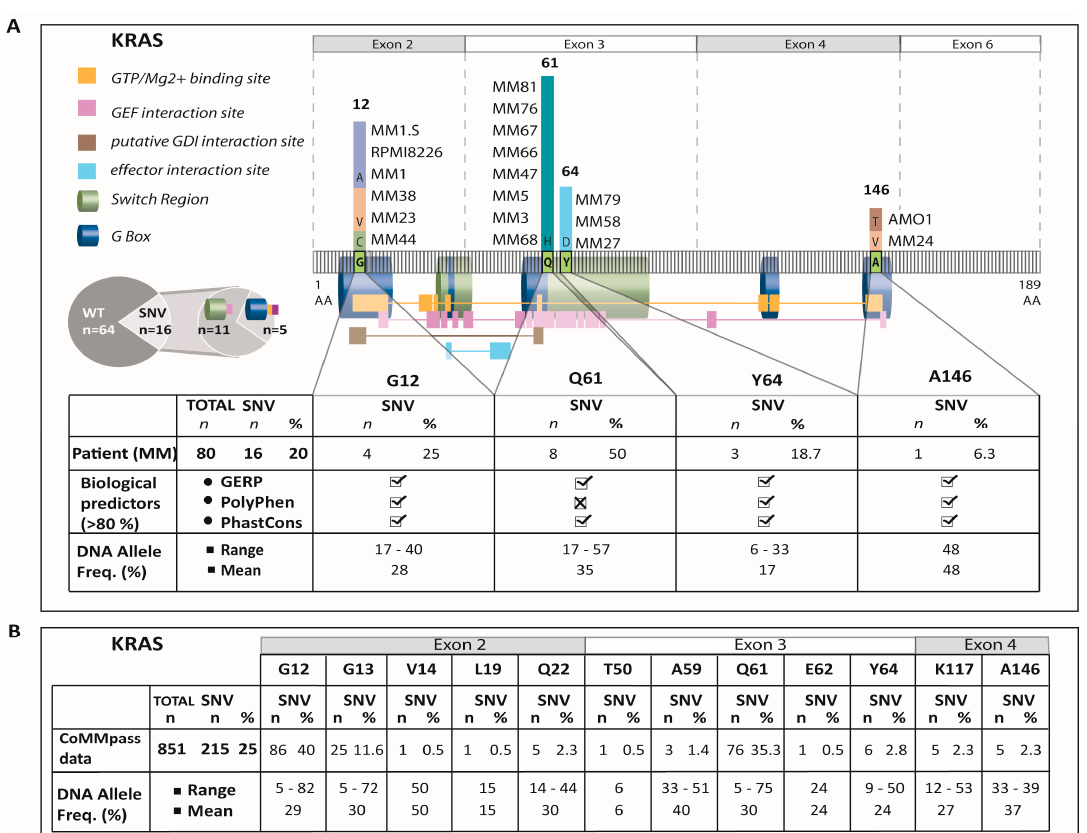
Table 1. Correlation of the KRAS mutation-status with classic cytogenetic parameters. mut: mutation, WT: wild